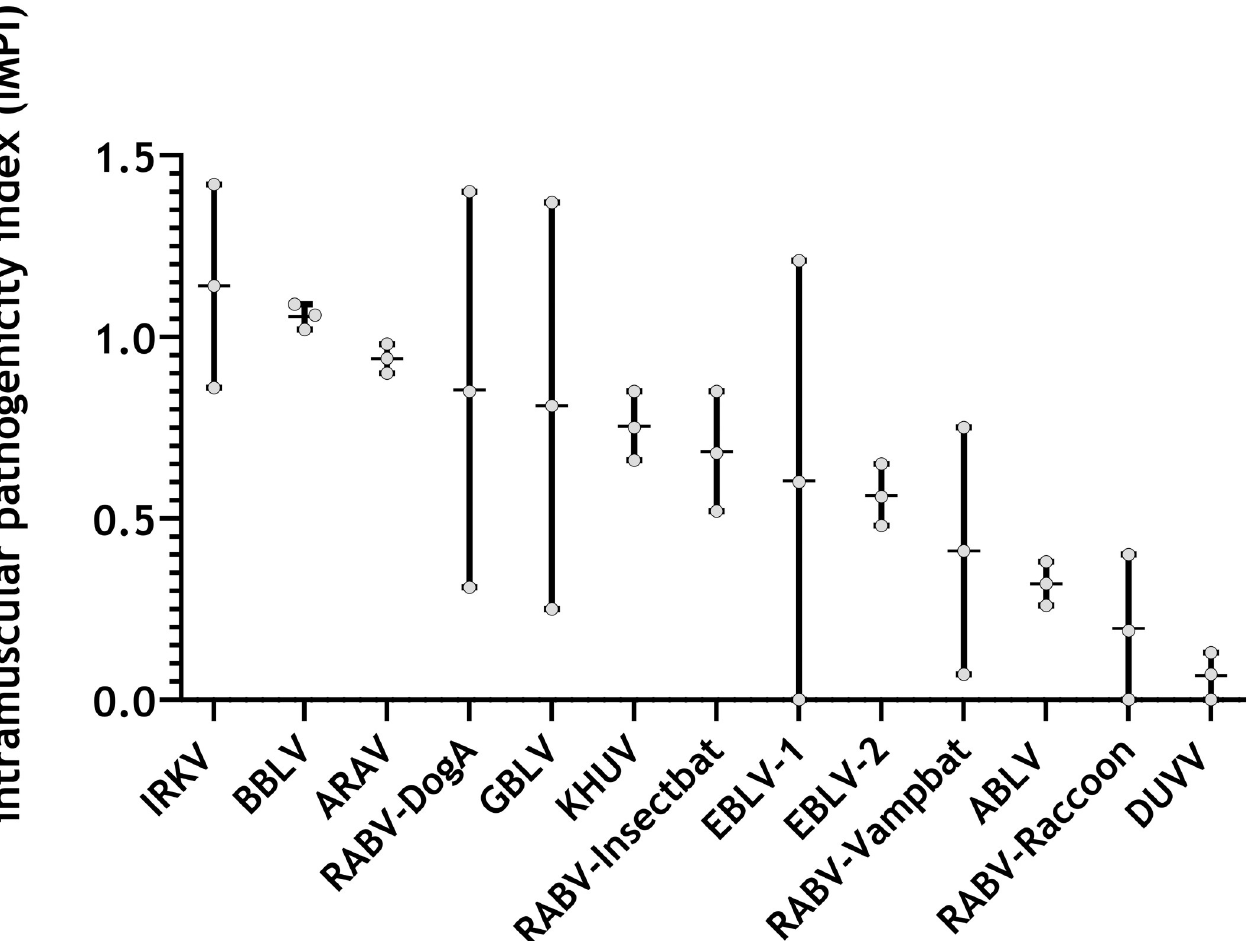
Fig 6. Intramuscular pathogenicity index (IMPI) of the different lyssavirus isolates obtained in the mouse model. Depicted are mean pathogenicity indices (median bar) of combined datasets of i.m. low (lower values) and high dose (upper values) infected animals. A maximum index value of 2 would be reached if all mice died at day 1